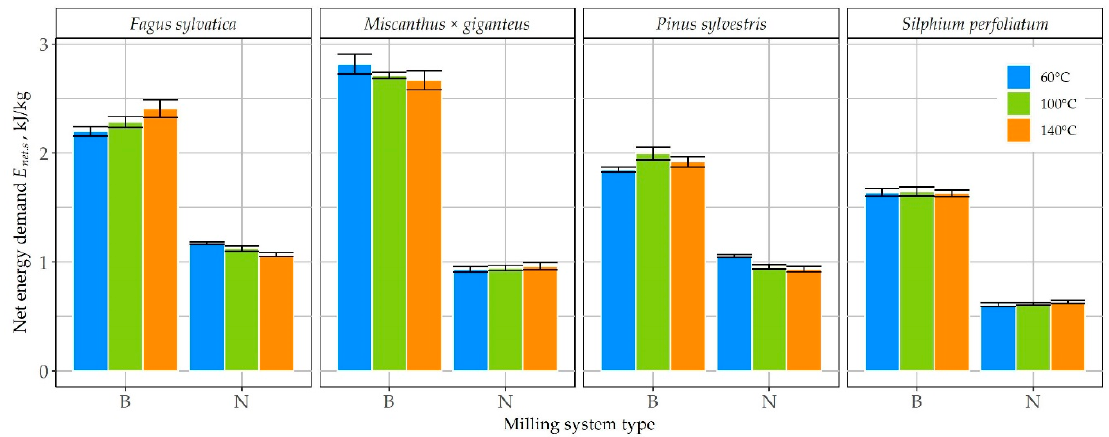
Figure 12. Values of net energy demands; B is the hammer and N is the knife grinding system.